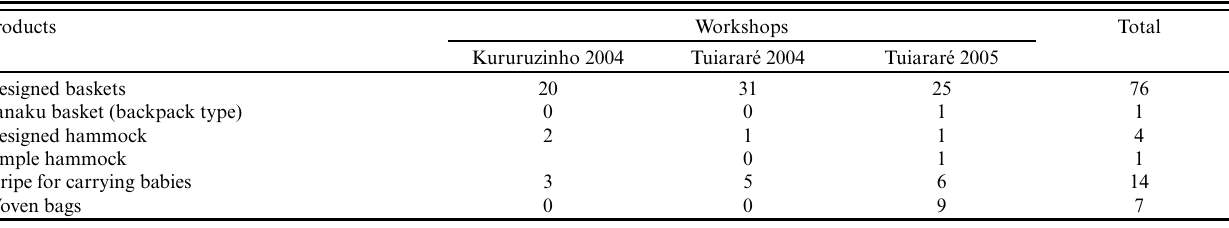
Table 1 . Outcomes of the Kaiabi Araa project workshops. Objects and designs produced by the participants in Tuiararé and Kururuzinho villages from 2004 and 2005.